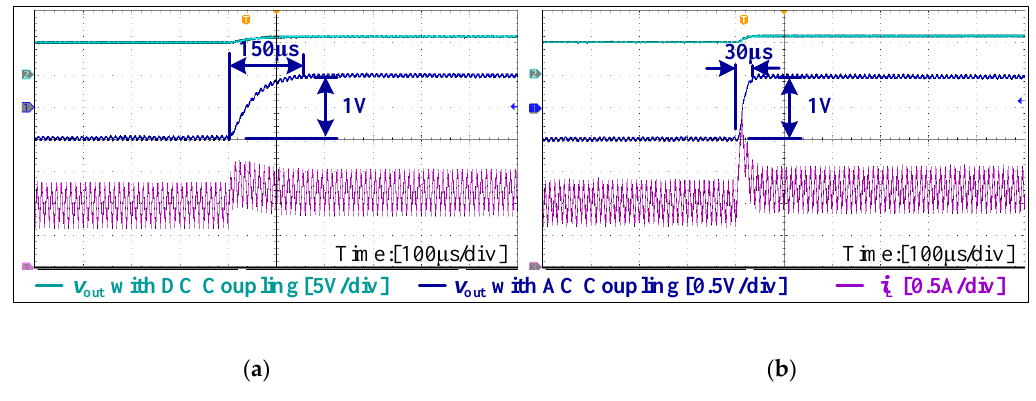
Figure 20. Transient voltages and current when v in steps from 12 to 9.5 V: ( a ) Digital current mode control with PID compensation and ( b ) DPVP control.